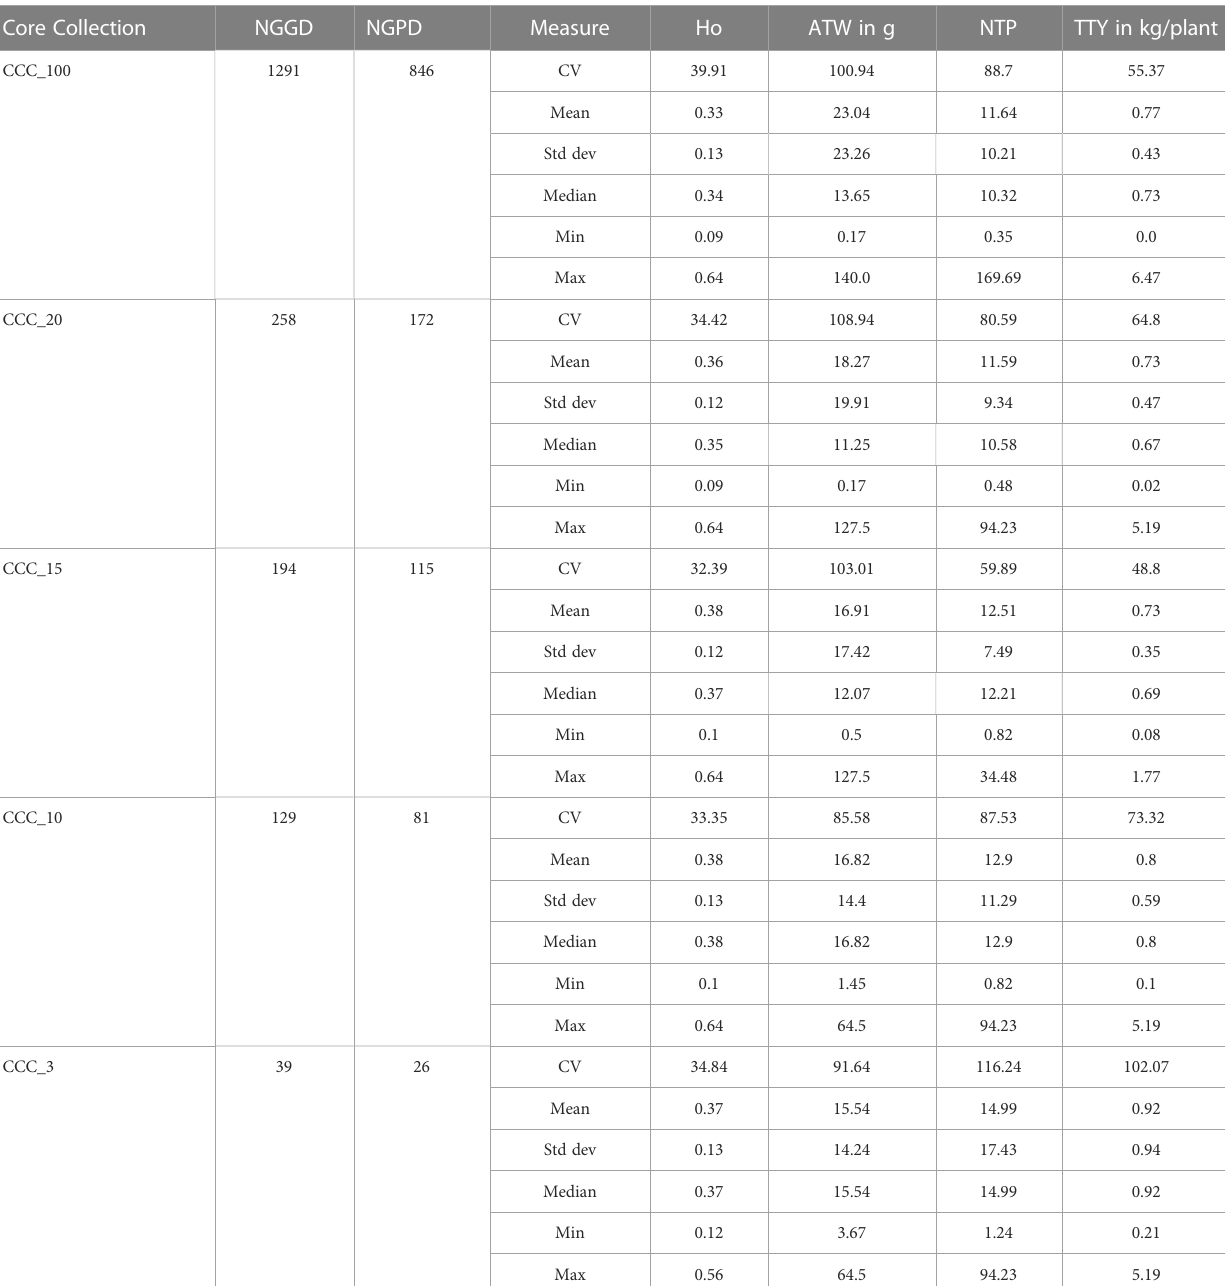
TABLE 3 Measures of central tendency (mean and median) and dispersion [coef fi cient of variation (CV), standard deviations (Std Dev), minimal (min) and maximum (Max) values] for the observed Heterozygosity (Ho), Average Tuber Weight (ATW), Number of Tubers per Plant (NTP), and Total Tuber Yield (TTY) traits evaluated in the Colombian Central Collection (CCC_100) of potatoes and Core Collections sizes of 20 percent (CCC_20), 15 percent (CCC_15), 10 percent (CCC_10) and 3 percent (CCC_3) of the CCC proposed in this